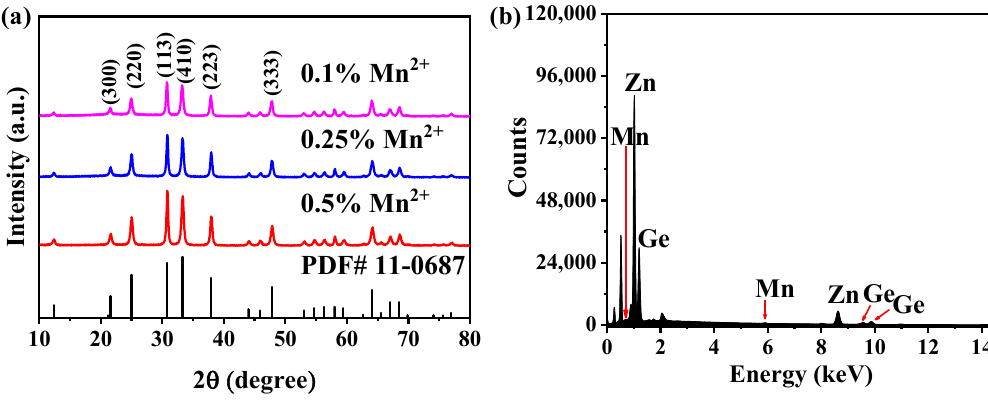
Figure 3. ( a ) XRD spectra of Mn 2 + -doped ZGO: Mn with 0.1%, 0.25% and 0.5% Mn. ( b ) EDS spectrum of Zn 2 GeO 4 containing 0.5% Mn (ZGO:0.5% Mn).